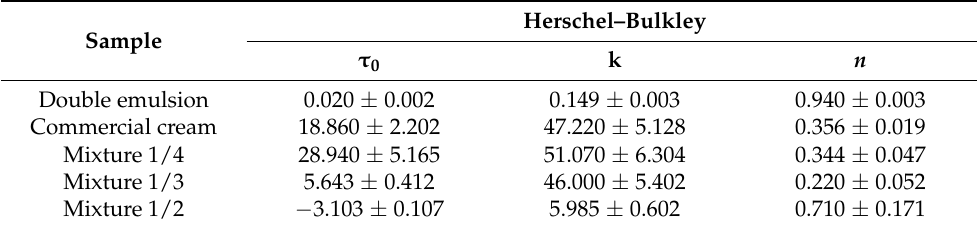
Table 1. Parameter values obtained fitting the Herschel–Bulkley rheological model to flow curve data of measured